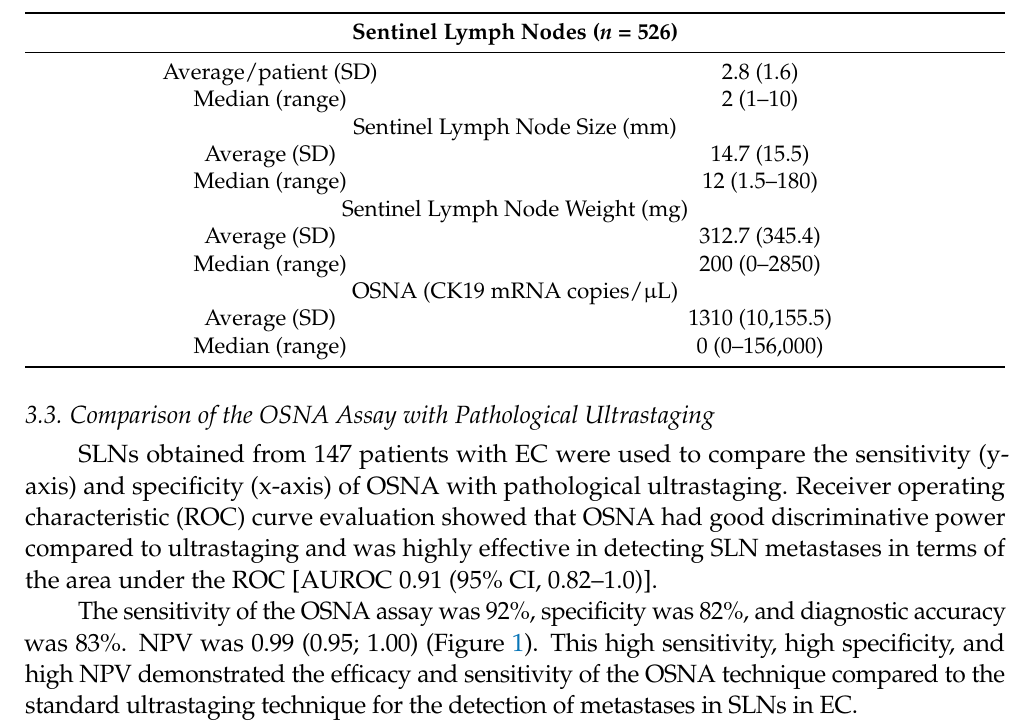
Table 2. Summary of sentinel lymph node characteristics.